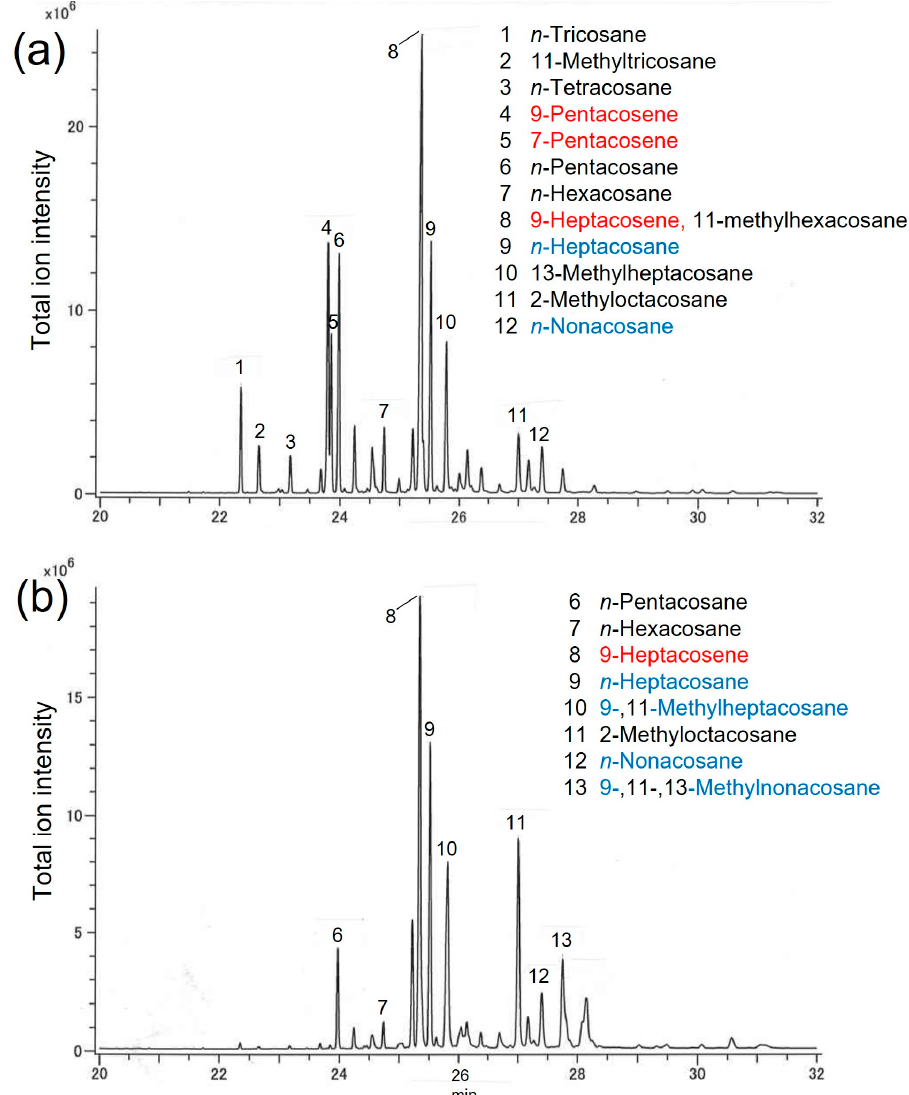
Figure 5. GC profiles of hexane fractions of female extract of ( a ) Anoplophora glabripennis , and ( b ) A. malasiaca . Olefin geometries were not determined. Compounds written in red are contact pheromone components of A. glabripennis and these in blue are those of A. malasiaca.